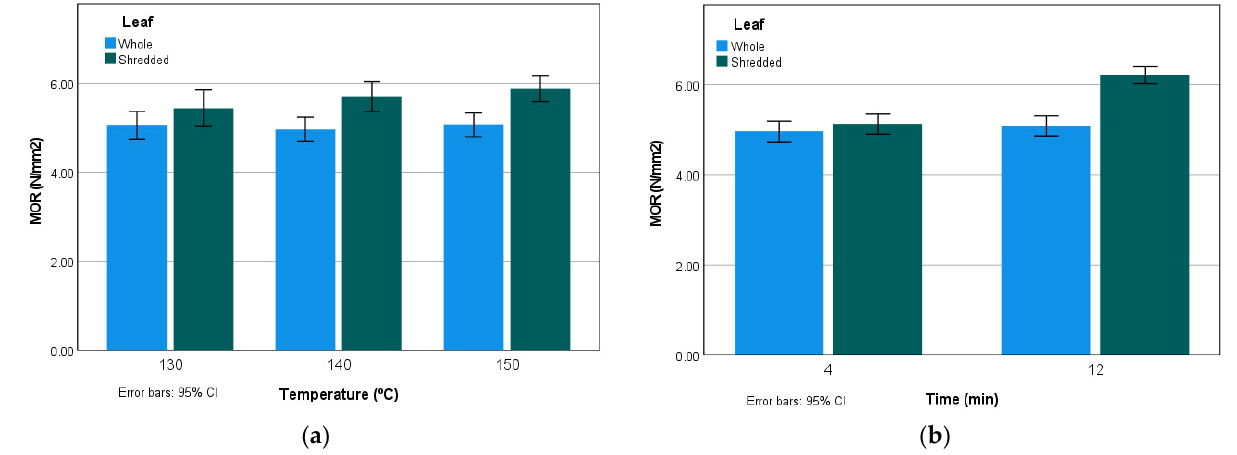
Figure 7. Modulus of rupture (MOR) according to ( a ) temperature and ( b ) pressing time.